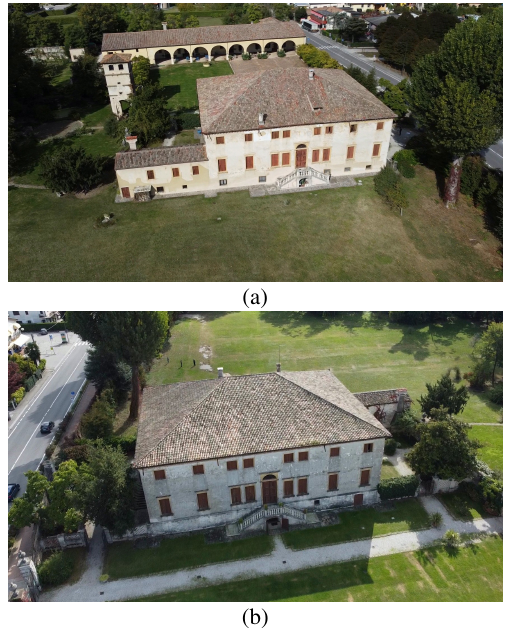
Figure 1. UAV views of Villa Roberti Brugine.